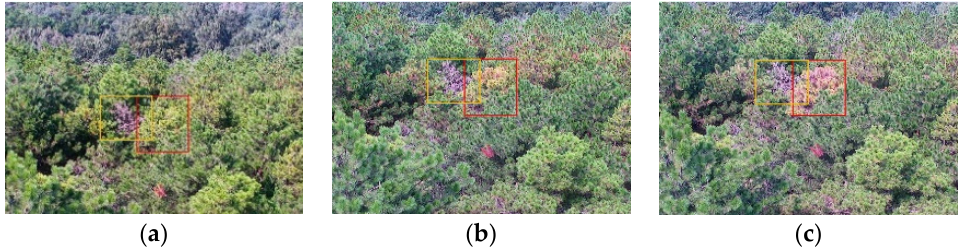
Figure 2. Photographs of the process of pine trees infected with pine wood nematode. ( a ) Photo- graphed on the first day. ( b ) Photographed on the tenth day. ( c ) Photographed on the twenty-fifth day.